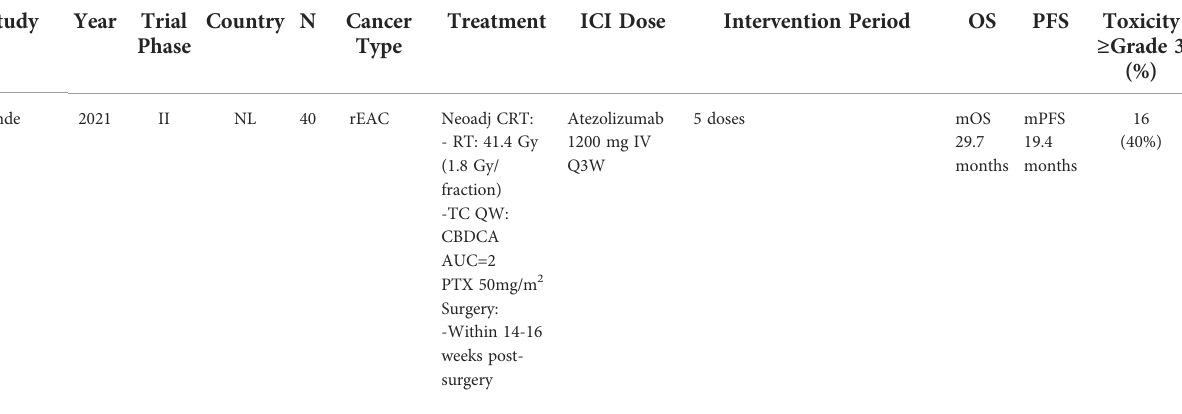
(Figure 3). The pooled rate of the other grades were not analyzed due to excessive heterogeneity, with few trials reporting related side effects. The rate of speci fi c adverse reactions are as follows: